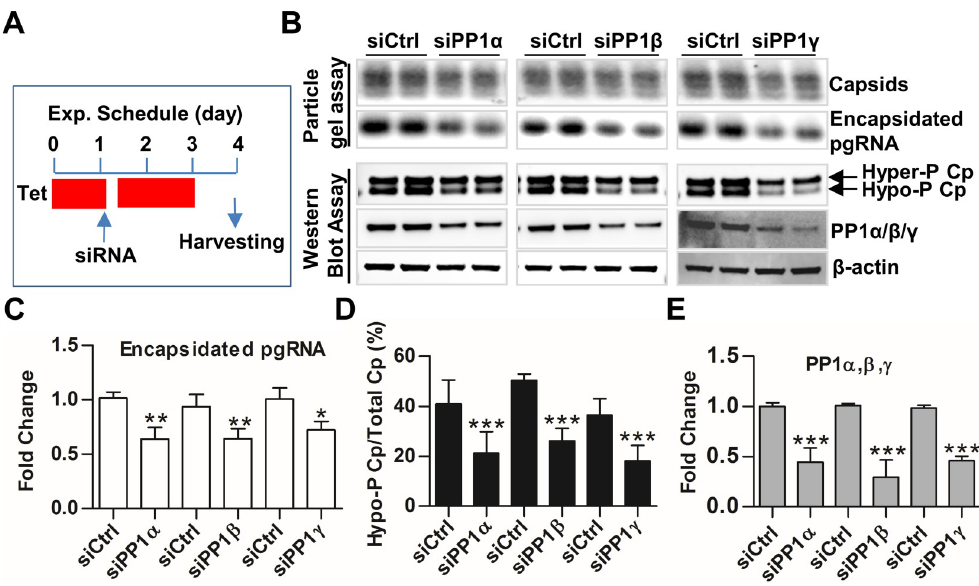
Fig 3. Knockdown of PP1 catalytic subunit isoforms reduced pgRNA packaging and Cp dephosphorylation. (A) Schematic illustration of experimental schedule. AML12HBVpolY63F cells were cultured in the presence of tet and transfected with 10 pmol siRNA targeting one of the PP1 catalytic isoforms or control siRNA by using Lipofectamine 2000 at 24 h post seeding. Six hours later, cells continued to be cultured in the presence of tet. At 48 h post transfection, cells were cultured in the absence of tet for another 24 h to allow pgRNA transcription and subsequent nucleocapsid assembly to occur. ( B ) Capsids and encapsidated pgRNA were detected by particle gel assay. The hyper/hypo-phosphorylated Cp and PP1 catalytic isoforms were detected by Western blot assays. β -actin served as a loading control. ( C to E ) The band intensity of capsids, encapsidated RNA, hyper- and hypo-phosphorylated Cp as well as the PP1 catalytic isoforms in panel B were quantified by Gelpro32 software. The amount of encapsidated pgRNA was normalized to the amount of total capsids in each sample and presented as a fraction of the amount in cells transfected with control siRNA (C). The extent of Cp dephosphorylation was expressed as the percentage of hypophosphorylated Cp in total Cp for each sample (D). The amount of PP1 catalytic isoform in each sample were normalized to the level of β -actin and presented as a fraction of the amount in cells transfected with control siRNA (E). Data were derived from three independent experiments. � P < 0.05, �� P < 0.01, ��� P < 0.001, versus siCtrl (one-way